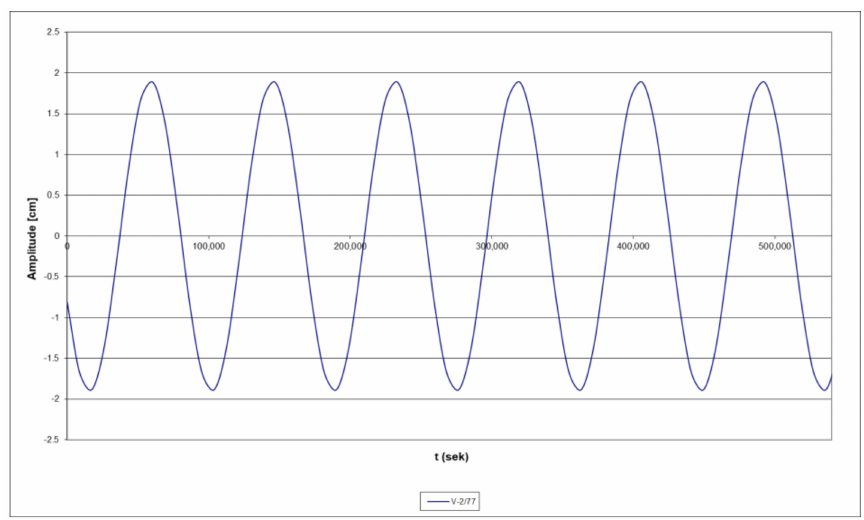
Figure 10. Synthetic record of groundwater oscillation in piezometer V-2/77 with period of 24.5 h.